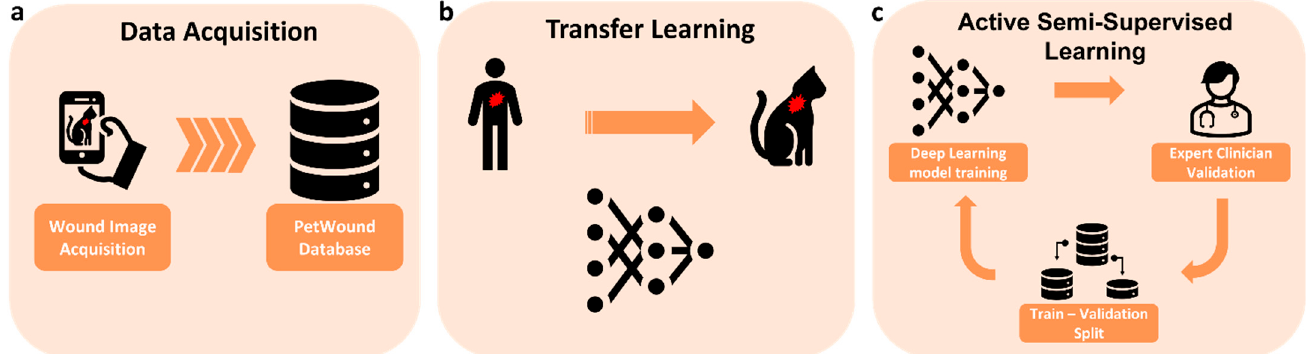
Figure 1. Representation of the pipeline implemented for the training of the EfficientNet-b3